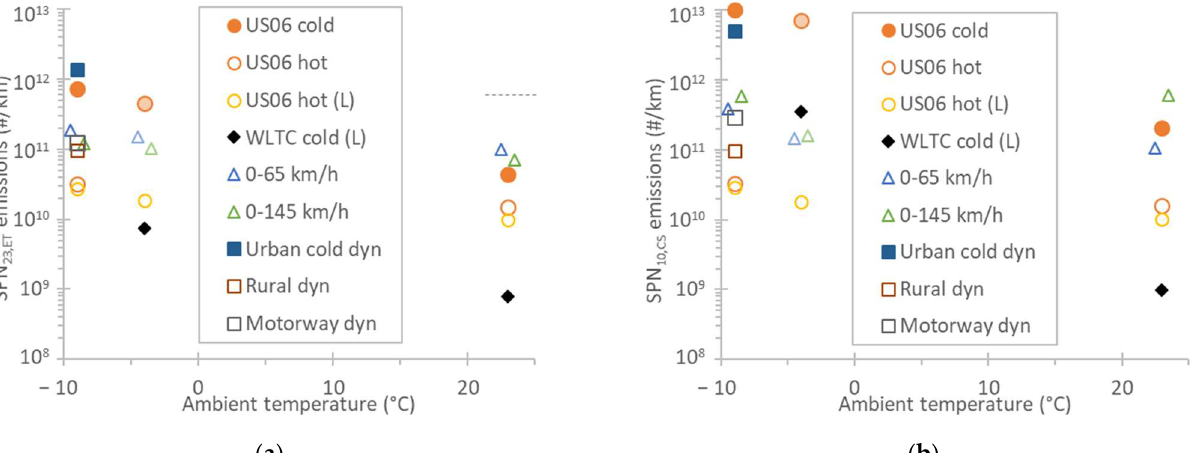
Figure 3. Emissions for various tests at different ambient temperatures. All tests with 84% payload (1850 kg test mass), except those with “L” and the − 4 ◦ C tests where the test mass was lower (1550 kg). Solid symbols are cold start tests, while open symbols are hot start tests. Lighter colors indicate tests with lower payload (mass). Auxiliaries were activated only at the − 9 ◦ C tests. ( a ) Solid particle number >23 nm with the evaporation tube (SPN 23,ET ). The dotted line shows the limit for the type approval cycle WLTC. ( b ) Solid particle number >10 nm with the catalytic stripper (SPN 10,CS